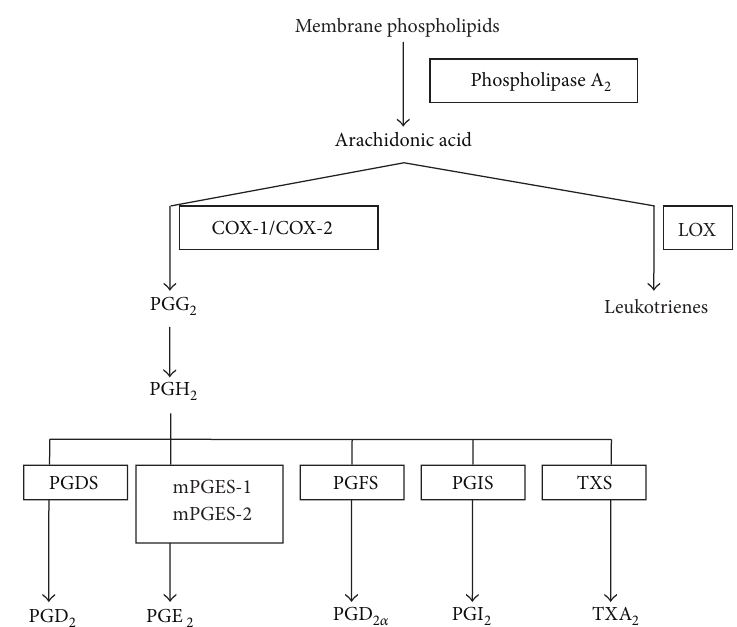
Figure 5: Biosynthesis of eicosanoid. (Adapted and modified from Dallaporta et al.